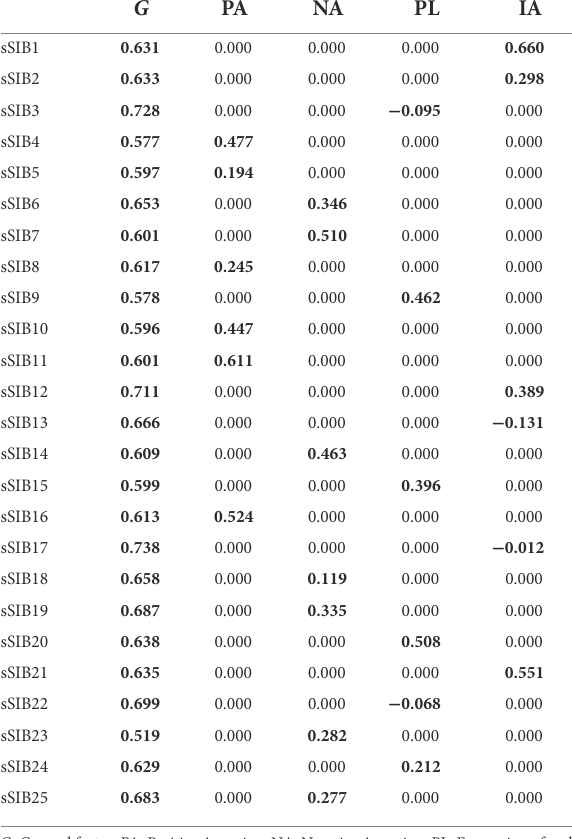
TABLE 3 Bifactor confirmatory IRT model – factor loadings for s-SIB performance. G PA NA